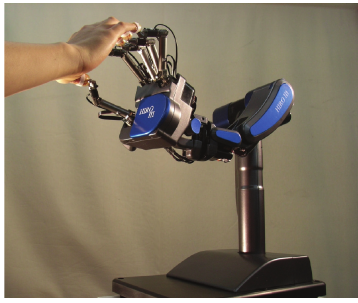
Figure 1: Five-fingered haptic interface robot: HIRO III. An oper- ator connects his/her five fingertips to HIRO III through passive spherical permanent magnet